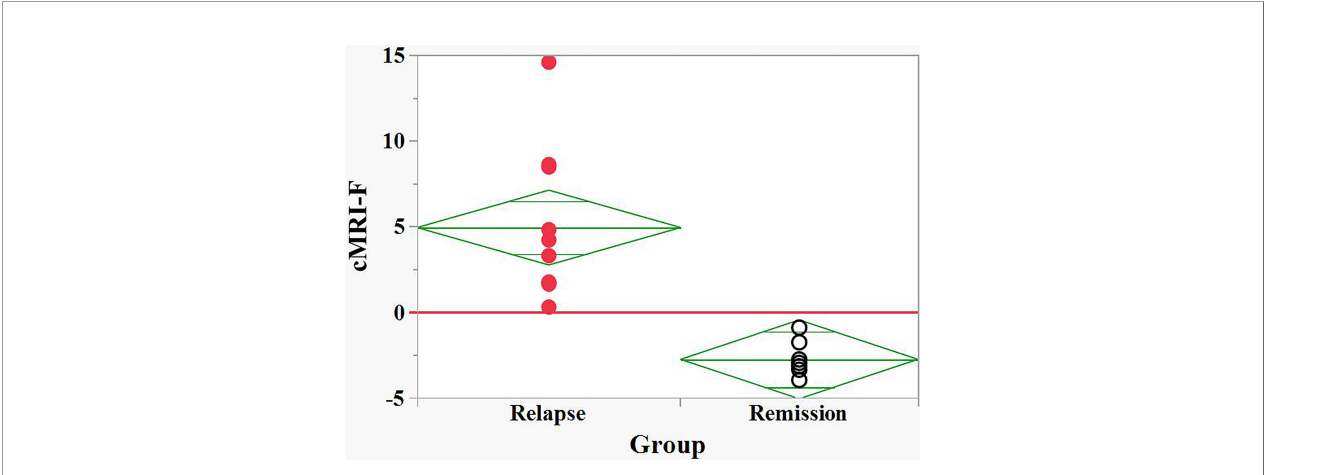
FIGURE 4 | Discrimination between relapse and remision groups of naive POMS patients by the MRI based Firth logistic regression function, cMRI-F. cMRI-F values were calculated for each individual ( Supplement 2 ). “ Relapse ” - red fi lled circles, “ Remission ” - black empty circles. Effective discrimination between the POMS patients in relapse and remission groups was observed (cut-off value, cFLC-F = 0).